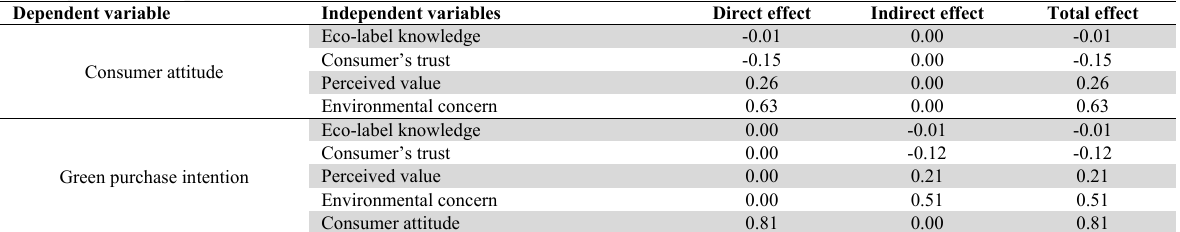
Decompositions of path coefficient